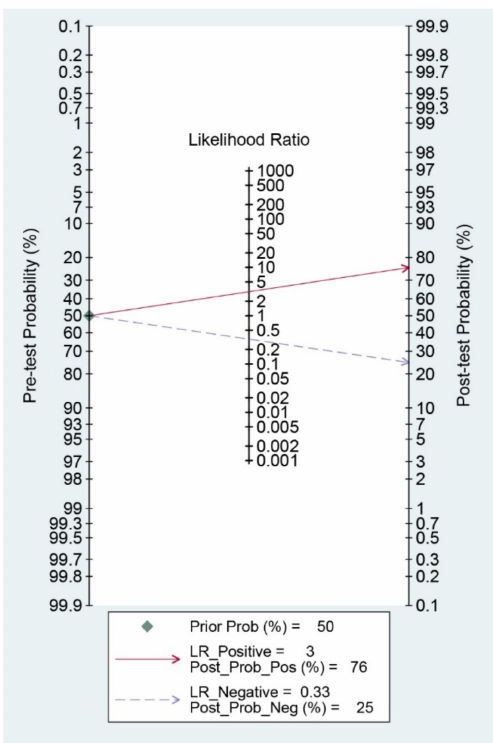
Figure 5. Fagan’s nomogram for the prediction of poor prognosis in gastrointestinal diseases.